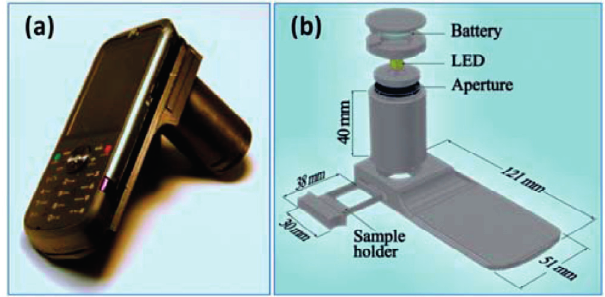
Figure 16. ( a ) A lensfree cellphone microscope which operates based on incoherent in-line holography is shown. The additional hardware installed on the cellphone weighs ~38 g (<1.4 ounces) and is composed of an inexpensive light emitting diode (at 587 nm) with an aperture of ~100 mm in front of the source. This cellphone microscope does not utilize any lenses or other bulky optical components and operates with a unit fringe magni fi cation to claim the entire active area of the sensor as its imaging fi eld of view. The samples to be imaged are loaded from the side through a mechanical sample holder. ( b ) Schematic diagram of the microscope attachment shown in (a) is illustrated (Reproduced with permission from [85]).